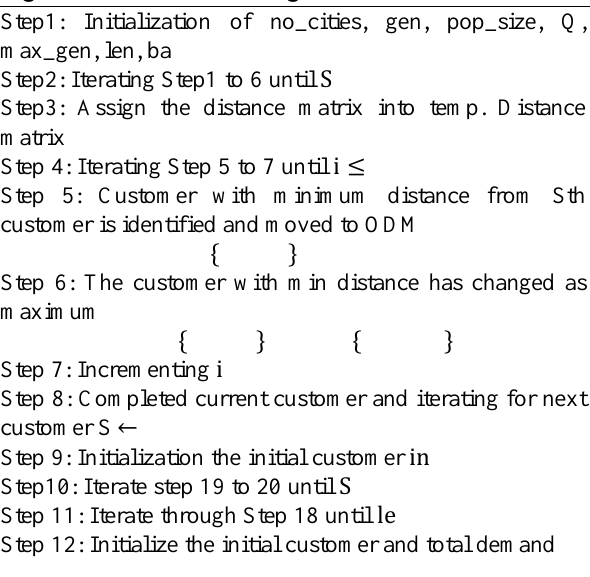
Algorithm for MDVRP using ODV-